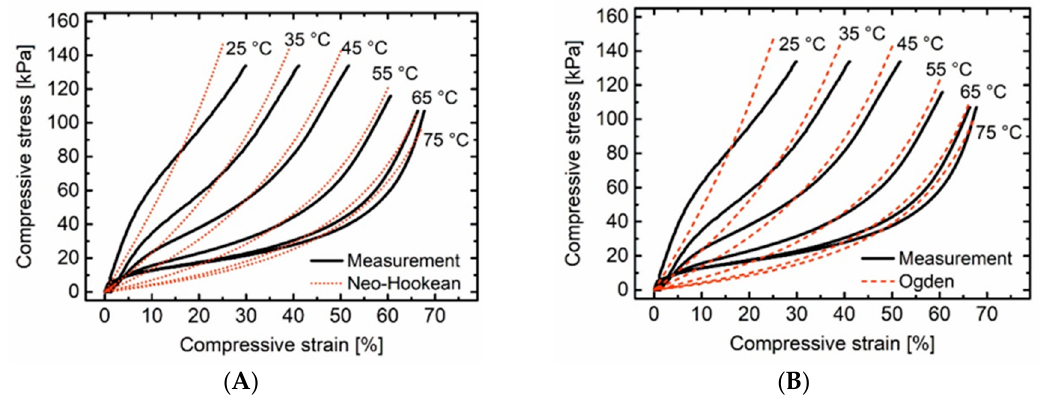
Figure 6. Results of compression tests on PEUU foam at different temperatures and prediction for the evolution of the stress-strain relations as obtained by the Neo-Hookean model ( A ) and the Ogden model ( B ).